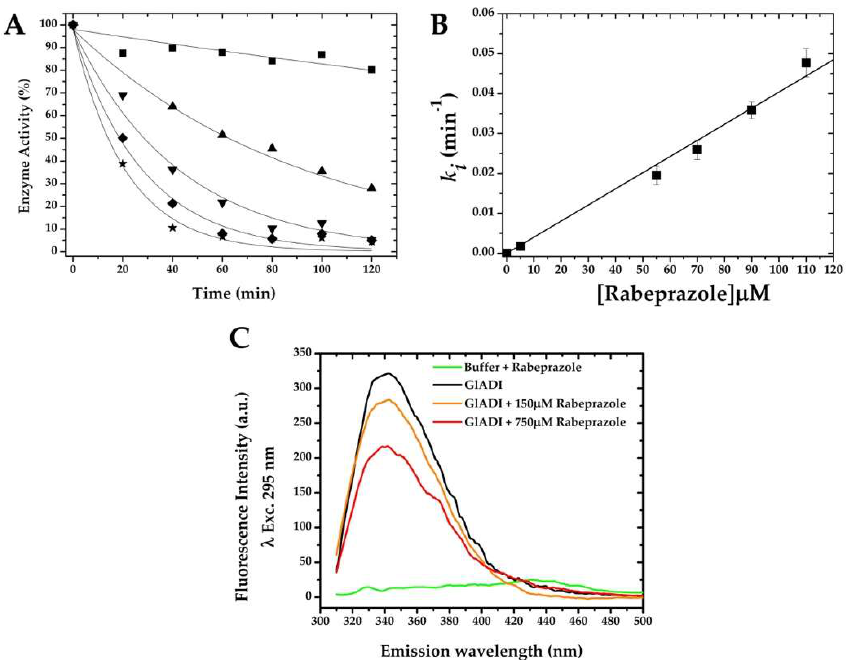
Figure 5. Effect of rabeprazole on the inactivation and intrinsic fluorescence of GlADI. ( A ) GlADI was incubated with 5 ( (cid:4) ), 55 ( (cid:78) ), 70 ( (cid:72) ), 90 ( (cid:117) ), and 110 µ M ( (cid:70) ) of rabeprazole at 25 ◦ C. ( B ) Inactivation rate constants at each concentration were plotted and fitted to a linear equation model, where the slope represents the second-order inactivation rate constant. ( C ) Measure of the fluorescence intensity of GlADI in the presence and absence of rabeprazole.